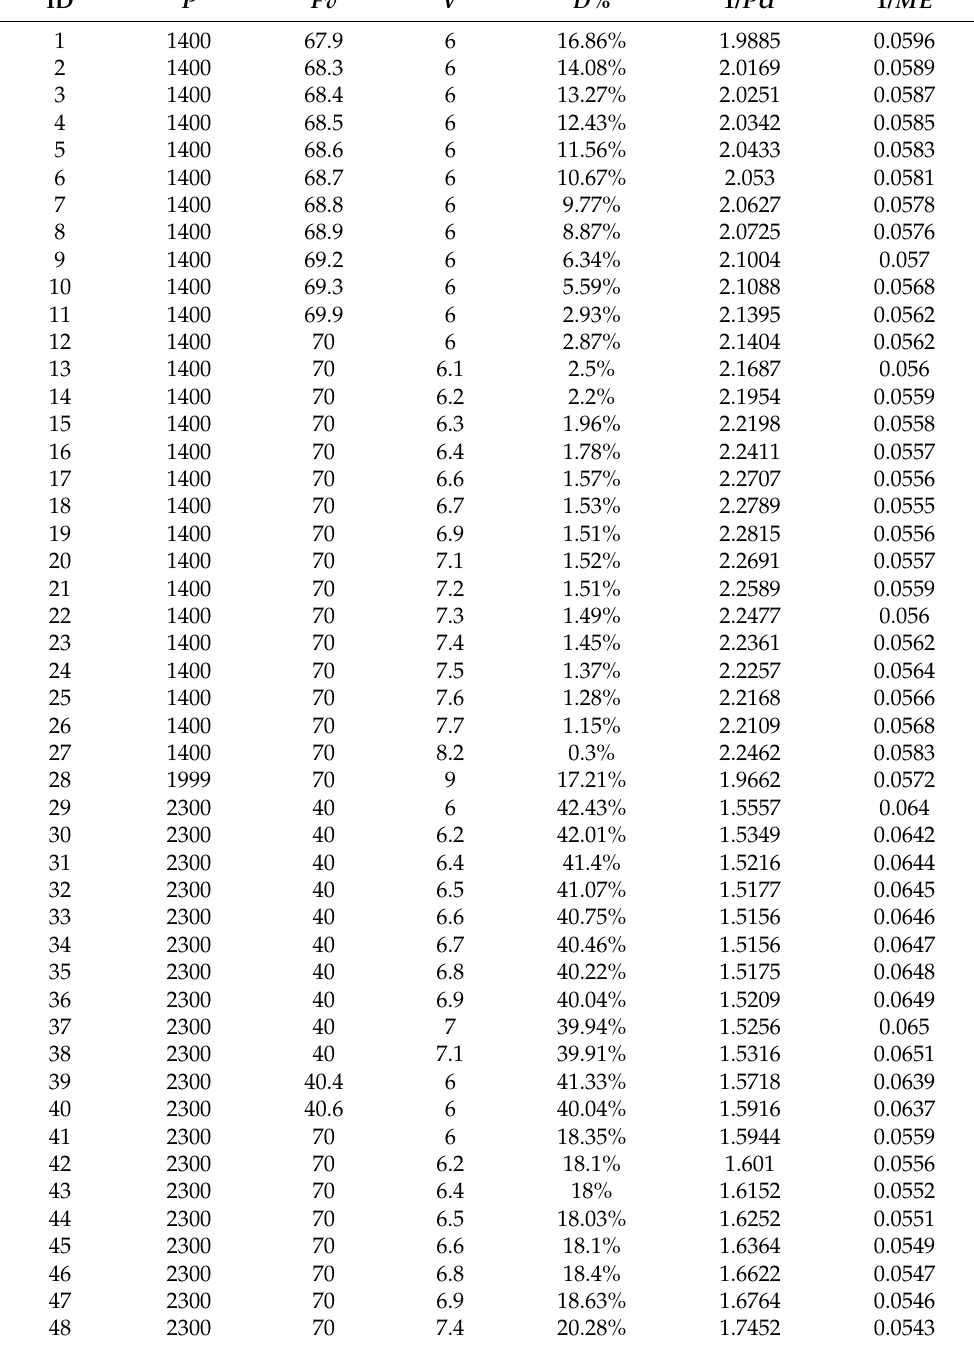
Table 4. Pareto optimal solutions and fronts of